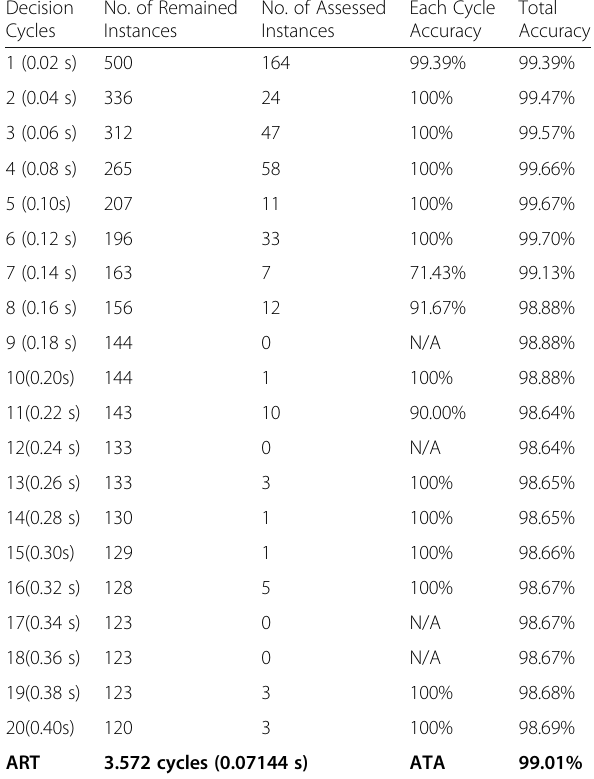
Table 1 POF solution results No. of Pareto Solutions